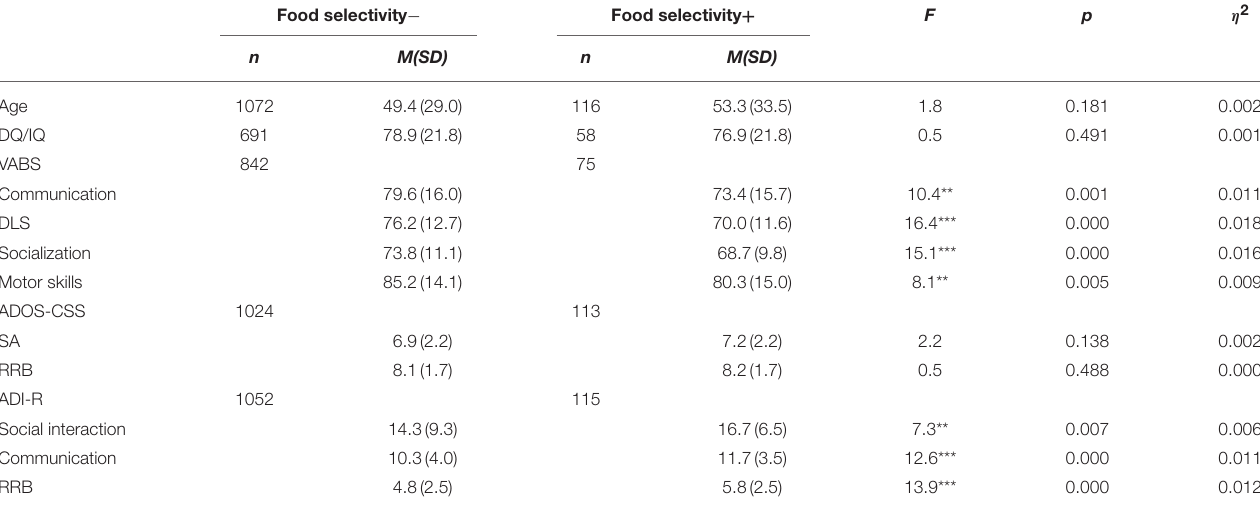
TABLE 4 | Mean and SD of cognitive scores, VABS scores and autism severity measures for the groups with and without food selectivity. Food selectivity − Food selectivity